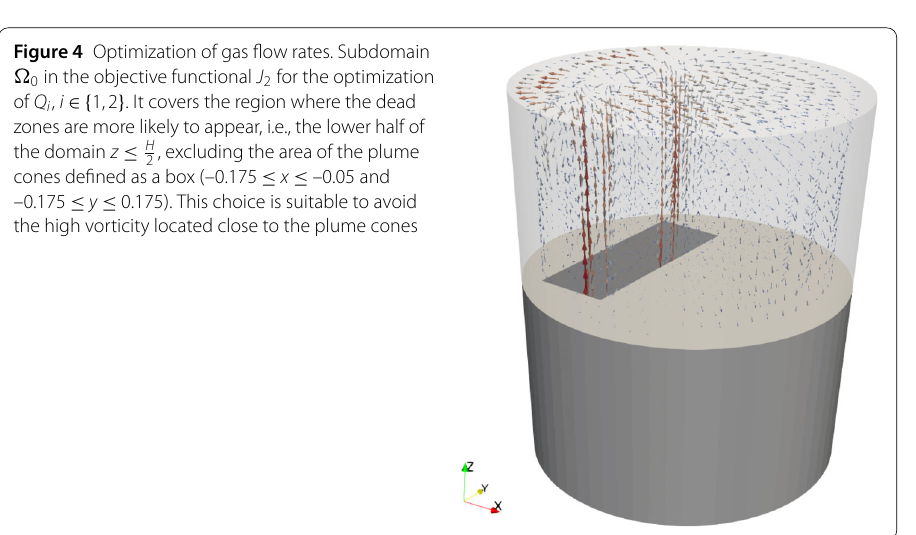
Figure 3 Optimization of gas flow rates. Averaged velocity field ¯ u obtained with (cid:18) t = 0.05 and C S = 0.005. This solution is used as the initial condition u 0 for the optimization studies which use the same (cid:18) t and C S